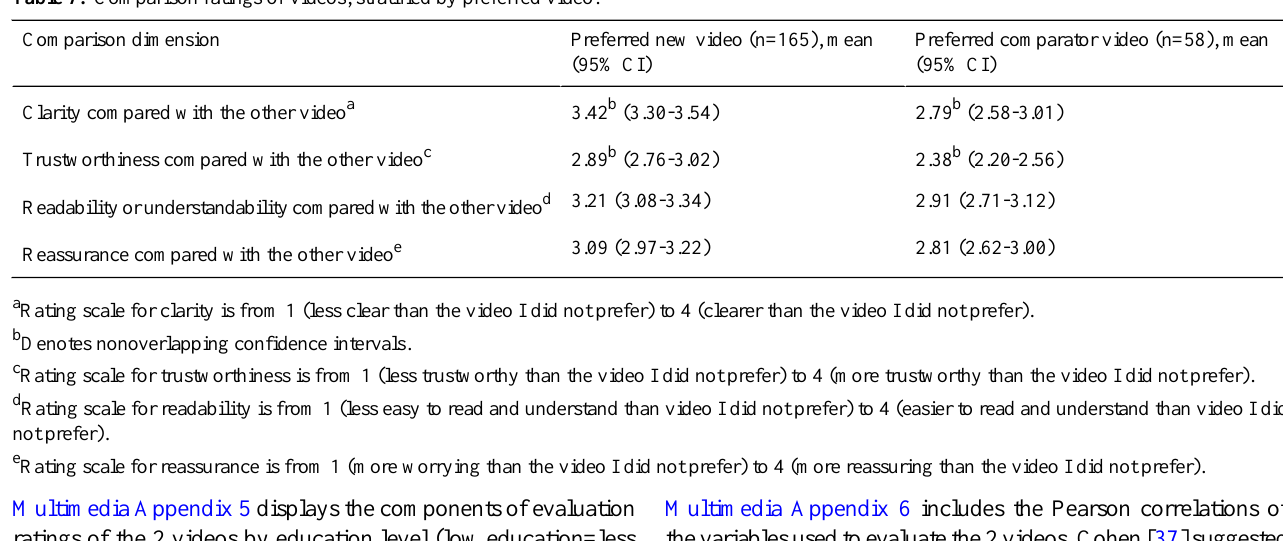
Table 7. Comparison ratings of videos, stratified by preferred